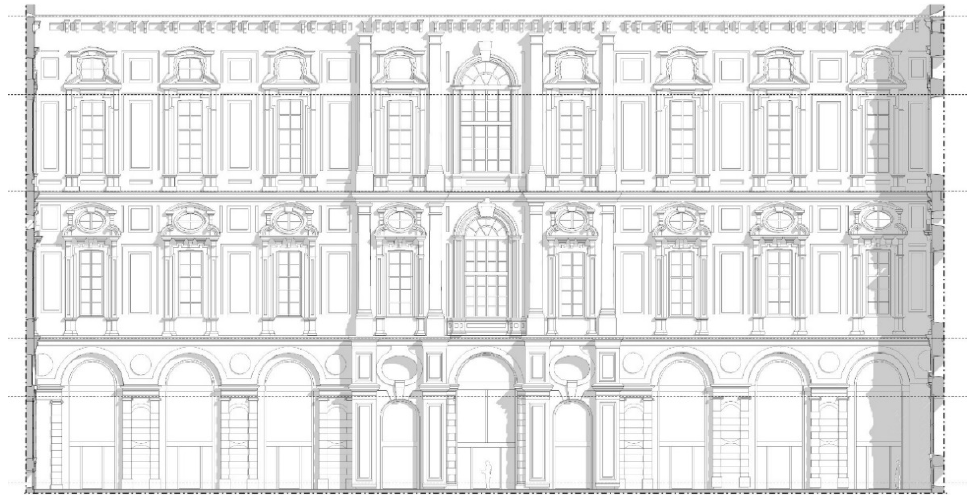
Figure 2. Internal facade of the Collegio dei Nobili. Image by the